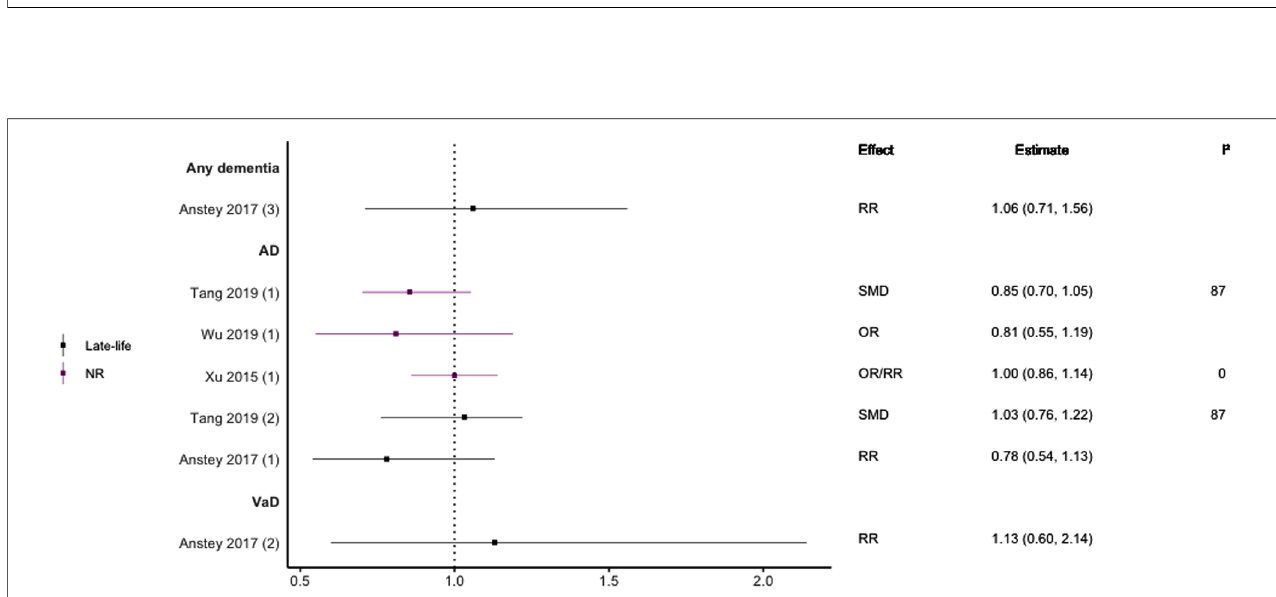
(cid:1) (cid:3) p (cid:2) SMD . AD, Alzheimer ’ s disease; OR, odds ratio; SMD, standard mean 3